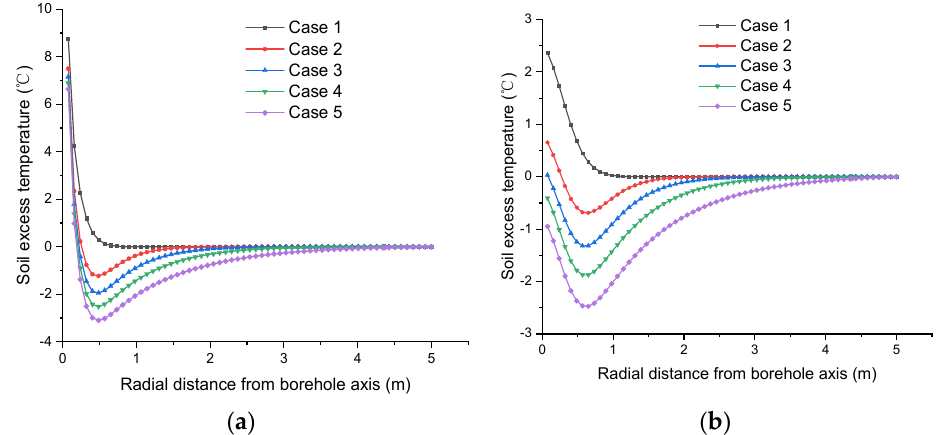
Figure 9. The distribution of soil excess temperature at the end of the operation and recovery period (at 12 h and 24 h) on the first day during the discharging process under different precooling times. ( a ) Operation period end; ( b ) Recovery period end.